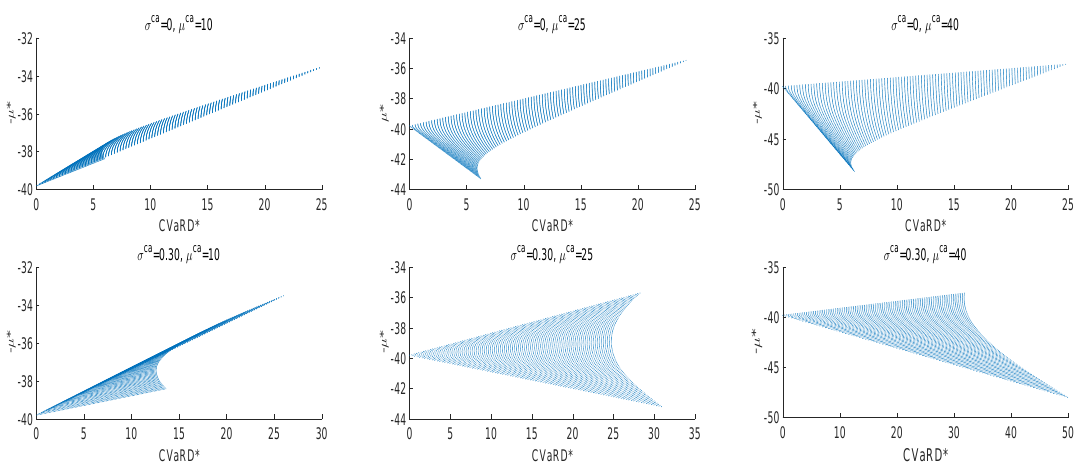
Figure 5. Systemic frontiers in the EEC mean-CVaRD plane ( − µ ∗ ,CVaRD ∗ ) under the two carbon volatility scenarios σ ca = 0 (top) and σ ca = 30% (bottom) for µ ca = 10, 25, 40 (from left to